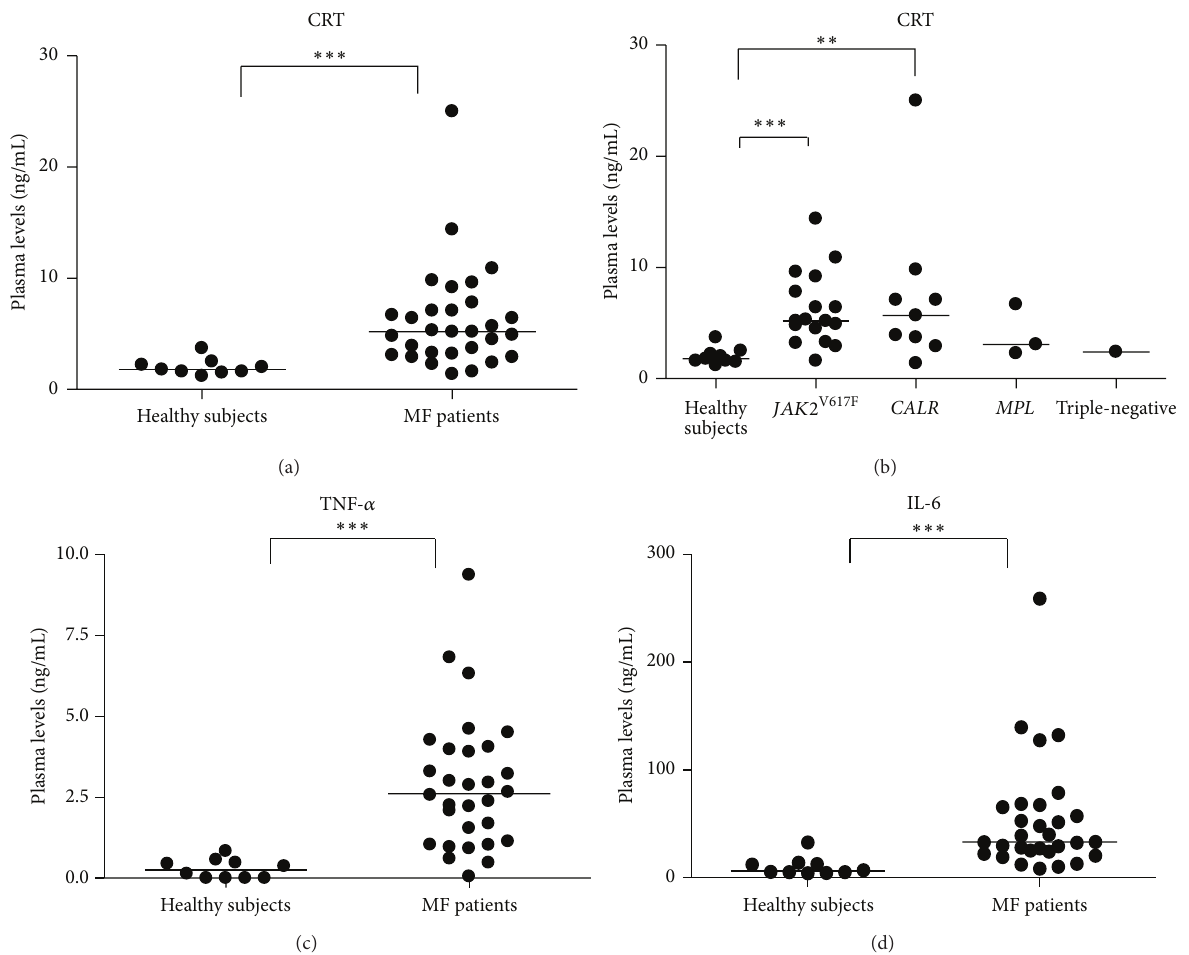
Figure 1: Analysis of the circulating levels of CRT, IL-6, and TNF- 𝛼 proteins . The CRT plasma levels of total MF (a) or MF subdivided into JAK2 𝑉617𝐹 -mutated ( 𝑛 = 16 ), CALR -mutated ( 𝑛 = 10 ), MPL -mutated ( 𝑛 = 3 ), and triple-negative-mutated ( 𝑛 = 1 ) groups (b) were measured byELISA.Comparedwithage-matchedcontrols(HD; 𝑛 = 10 ),CRTplasmalevelsweresignificantlyincreasedinMFpatients( 𝑝 = 0.0028 ).Of note, there was no significant difference between the mutated groups. Irrespective of mutational status, TNF- 𝛼 (c) and IL-6 (d) blood plasma levels were also increased in MF ( 𝑝 = 0.008 ). For all graphs, one symbol represents one individual, and the height of the bar represents the median value. ∗∗ 𝑝 ≤ 0.01 ; ∗∗∗ 𝑝 ≤ 0.001